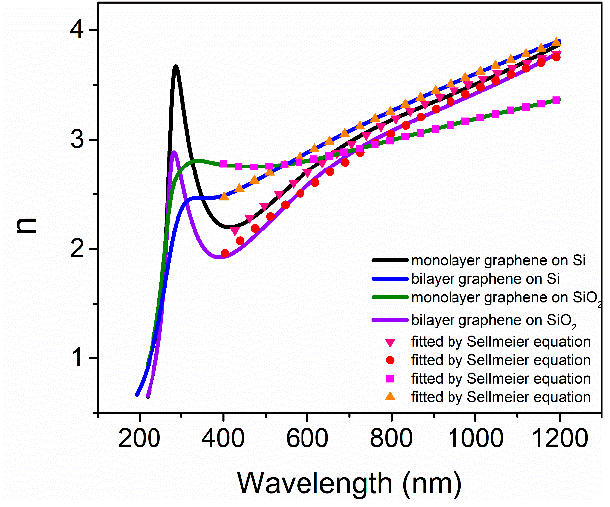
Figure 6. The refractive indices of graphene on Si and on SiO 2 /Si substrates fitted by a like-Sellmeier Equation (1) in the wavelength range of 400–1200 nm. Table 3. Fitting parameters of graphene on Si and on SiO 2 /Si substrates by using a like-Sellmeier Equation (1). Graphene Samples